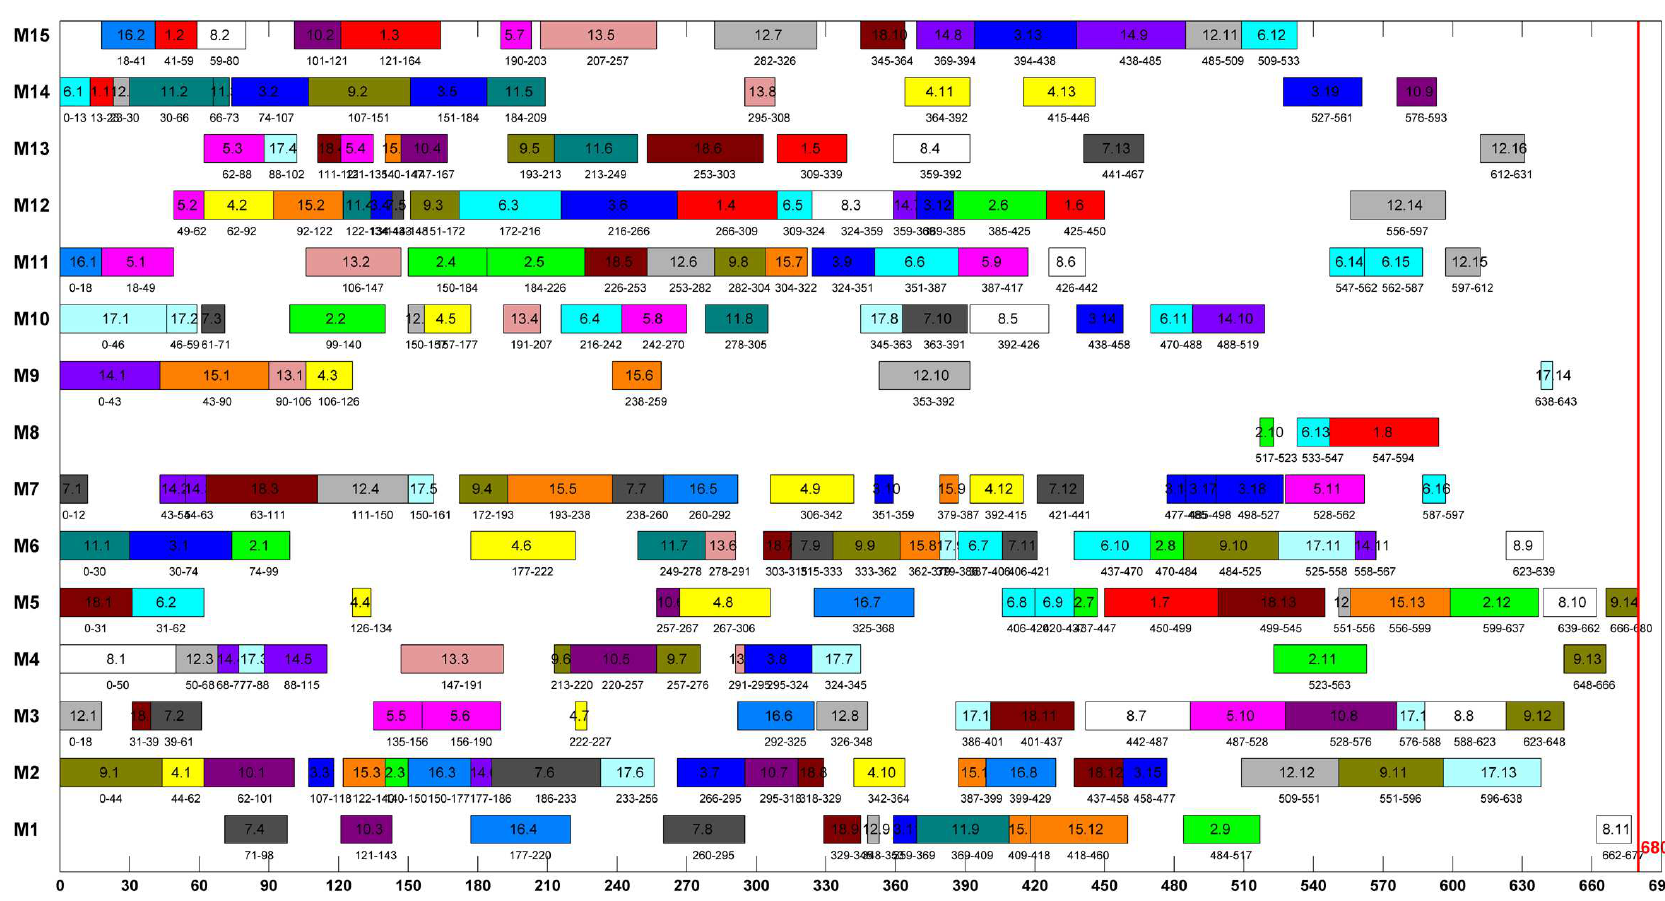
Figure 9. The Gantt chart that considers both the two